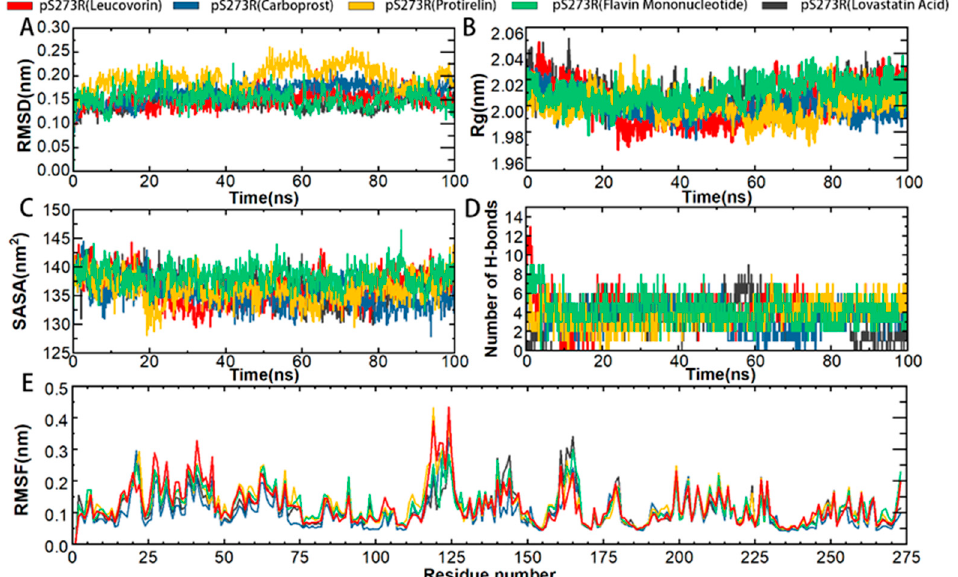
Figure 6. Molecular kinetics simulation of pS273R and its putative drug molecular complex over 100 ns. ( A ) Skeleton Carbon RMSD. ( B ) Rg of pS273R α carbon atoms. ( C ) pS273R α Carbon SASA. ( D ) Number of H ‐ bonds between the drug and pS273R. ( E ) RMSF of pS273R residues.